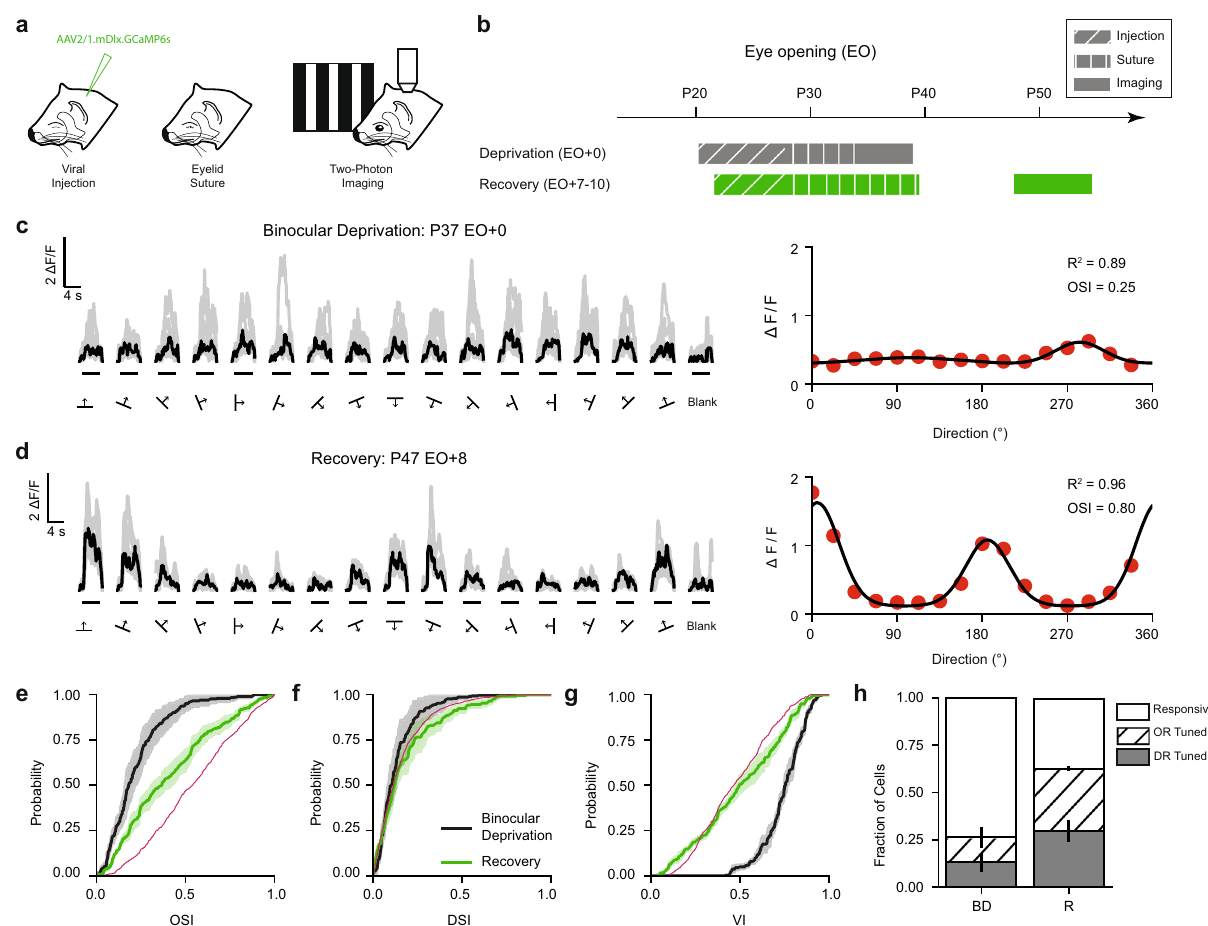
Fig. 4 Development of orientation preference in interneurons requires visual experience. a Two-photon imaging of viral expression of GCaMP6s under the mDlx enhancer in ferret visual cortex after binocular eyelid suture. The ferret images were created by the authors and published in Smith, G.B., Sederberg, A., Elyada, Y.M., Van Hooser, S.D., Kaschube, M., and Fitzpatrick, D., The development of cortical circuits for motion discrimination. Nat. Neurosci. 18, 252 – 261 (2015). b Two cohorts, Binocular Deprivation (EO + 0, 5 – 8 days of deprivation) and Recovery (EO + 8 – 15, 9 days of deprivation) were evaluated for GABA-IN responses to oriented stimuli. c Example cellular response to drifting gratings (left, black traces denote median response and gray traces denote single trials) and response tuning curve (right) for a binocularly deprived animal. d Example cellular response to drifting gratings (left) and response tuning curve (right) for a recovery animal. e – g Cumulative distributions of orientation selectivity index ( e ), Cumulative distributions of direction selectivity ( f ), and cumulative distributions of variability index ( g ) for BD (black, n = 4) and Recovery (green, n = 4) animals. Shaded regions denote SEM. Magenta line is provided as reference for Brief experience (see Fig. 1). h Fraction of cells that are responsive (white), orientation selective (hatched), and direction selective (gray) for Binocular Deprivation (BD, n = 4) and Recovery (R, n = 4) animals. Error bars denote SEM. Source data are provided as a Source Data fi